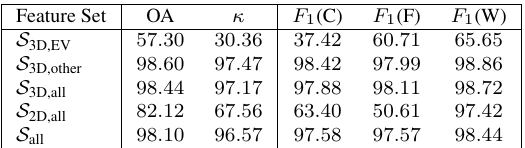
Table 2. Results (in %) achieved for the classification of the downsampled TLS dataset when using different feature sets as input for the classifier: Overall Accuracy (OA), κ -Index and class-wise F 1 -scores (C: Ceiling; F: Floor; W: